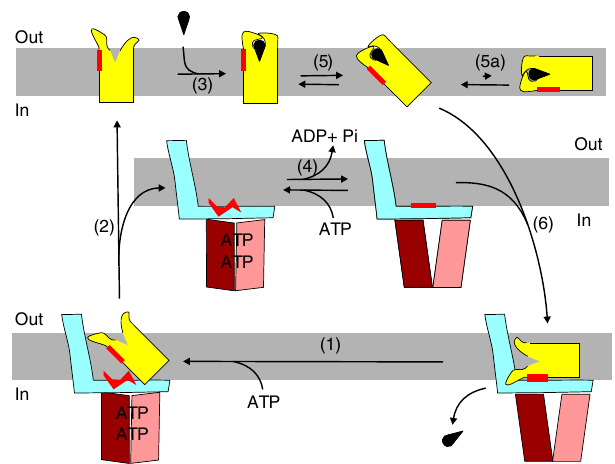
Figure 7 | Working model for the transport mechanism of group II ECF transporters. Colours of the subunits as in Fig. 3. Starting with the complex trapped in the post-translocation state, binding of ATP is needed to release the empty S-component by disruption of the hydrophobic interface (red) (step (1)). The S-component will reorient to the outward-facing state (2) and can bind substrate on the extracellular side of the membrane (3). ATP hydrolysis in the ECF module regenerates the binding platform for the S-component (4). Possibly futile ATP hydrolysis takes place in this stage. The substrate-bound S-component can topple over in the membrane possibly aided by the vicinity of the ECF module (5). The toppled S-component binds to the ECF module via the complementary hydrophobic surfaces, coloured in red (6). Binding of the S-component to the ECF module forces the disruption of the substrate-binding site and release of the substrate into the